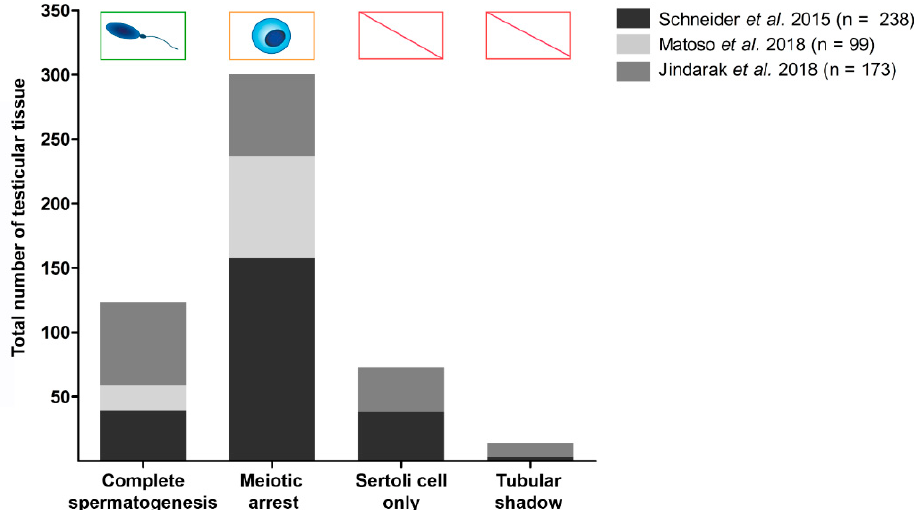
Figure 3. State of spermatogenesis of the testicular tissues of the transgender patients. Total numbers of testicular tissues with a specific state of spermatogenesis are shown in a cohort of 510 patients. Dark grey bars represent 238 testicular tissues [24], grey bars the results of 173 testicular tissues, and light grey bars the results of 99 testicular tissues [26]. The chance to isolate sperm and spermatogonia from respective tissues is indicated above the bars. Abbreviations stand for: CS: Complete spermatogenesis, MA: Maturation arrest, SCO: Sertoli cell only and TS: Tubular shadow.